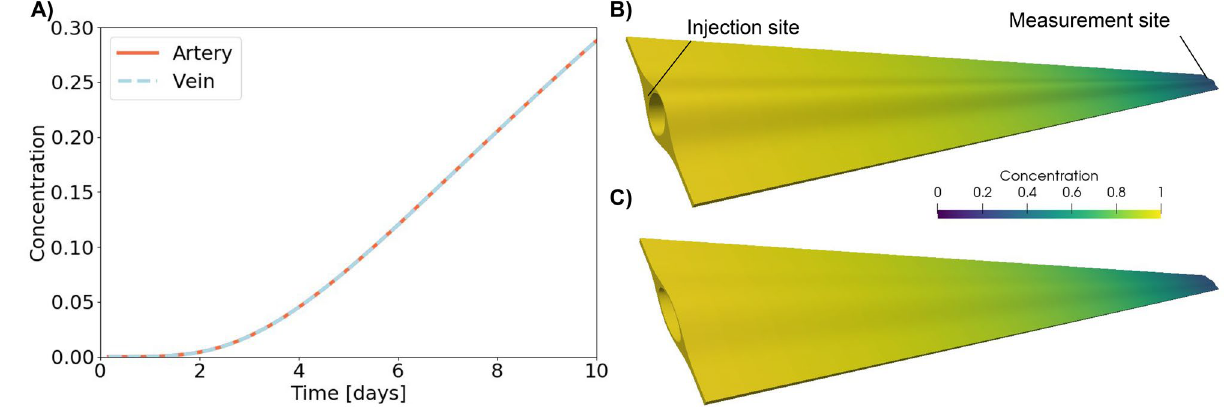
Figure 3. Diffusion of large (2000 kDa) tracers in PVS occurs on the time scale of days. In ( A ) the concentration of tracer at the point of measurement is shown for the artery and the vein. The two graphs are identical, showing that diffusion occurs at a similar rate in the two geometries. Tracer distribution after 10 days of diffusive transport is shown for the artery ( B ) and the vein ( C ).